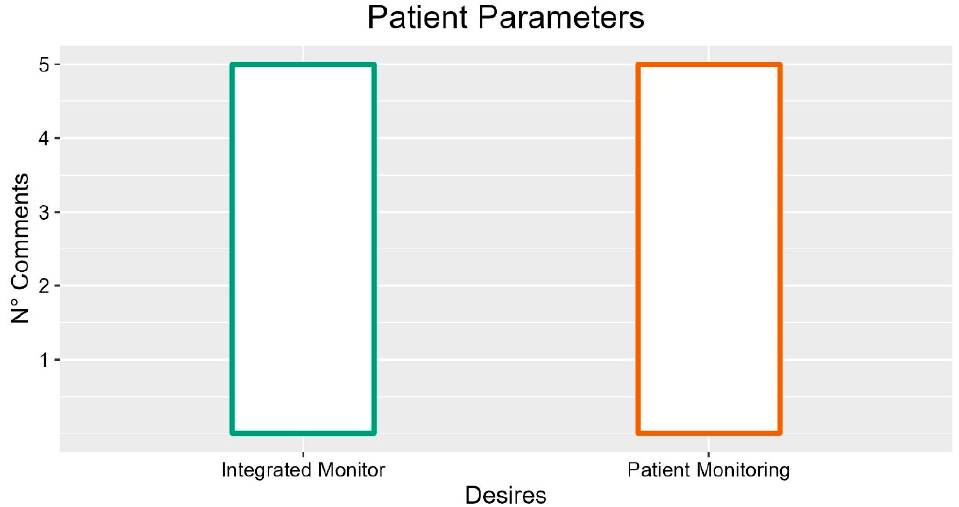
Figure 10. Graphical representation of desires with more occurrences for the Patient Parameters